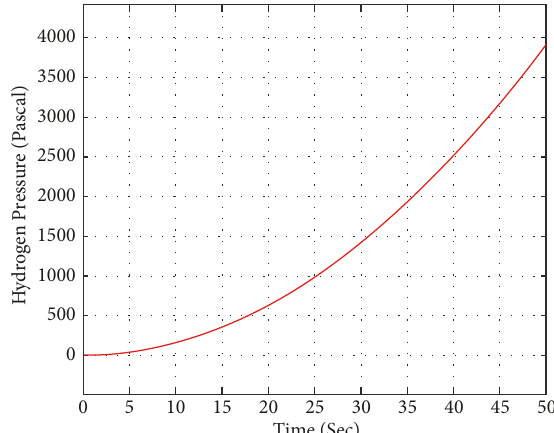
Figure 17: The pressure of compressed hydrogen